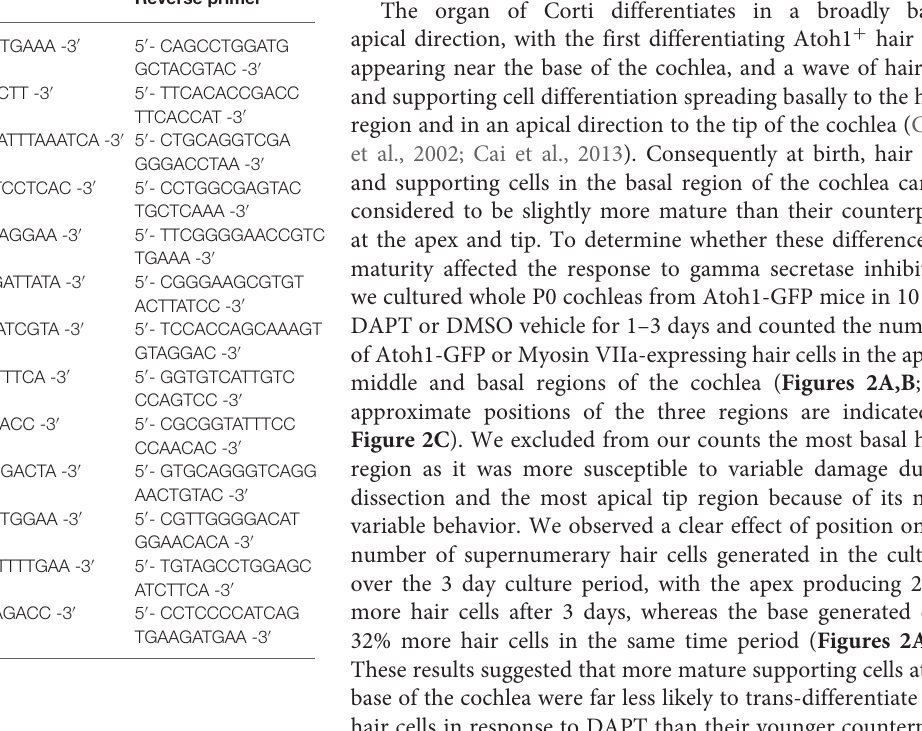
TABLE 2 | Q-PCR primers for Figure 6 . Gene Forward